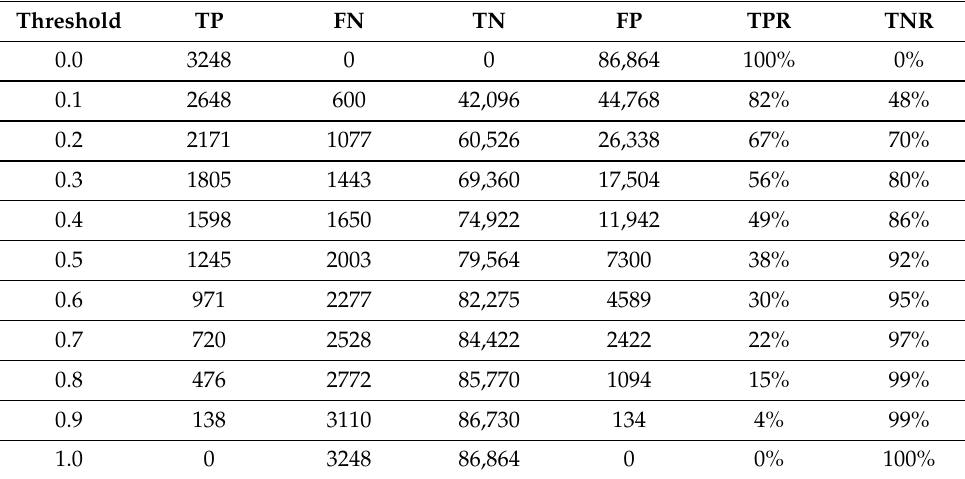
Figure 11. The ROC curve of 90,112 testing samples. Table 11. Performance with varying threshold value of 90,112 testing